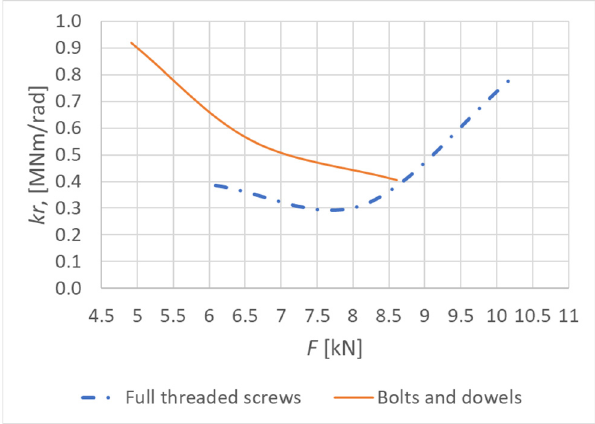
Figure 30. Comparison of the rotational stiffness trends.